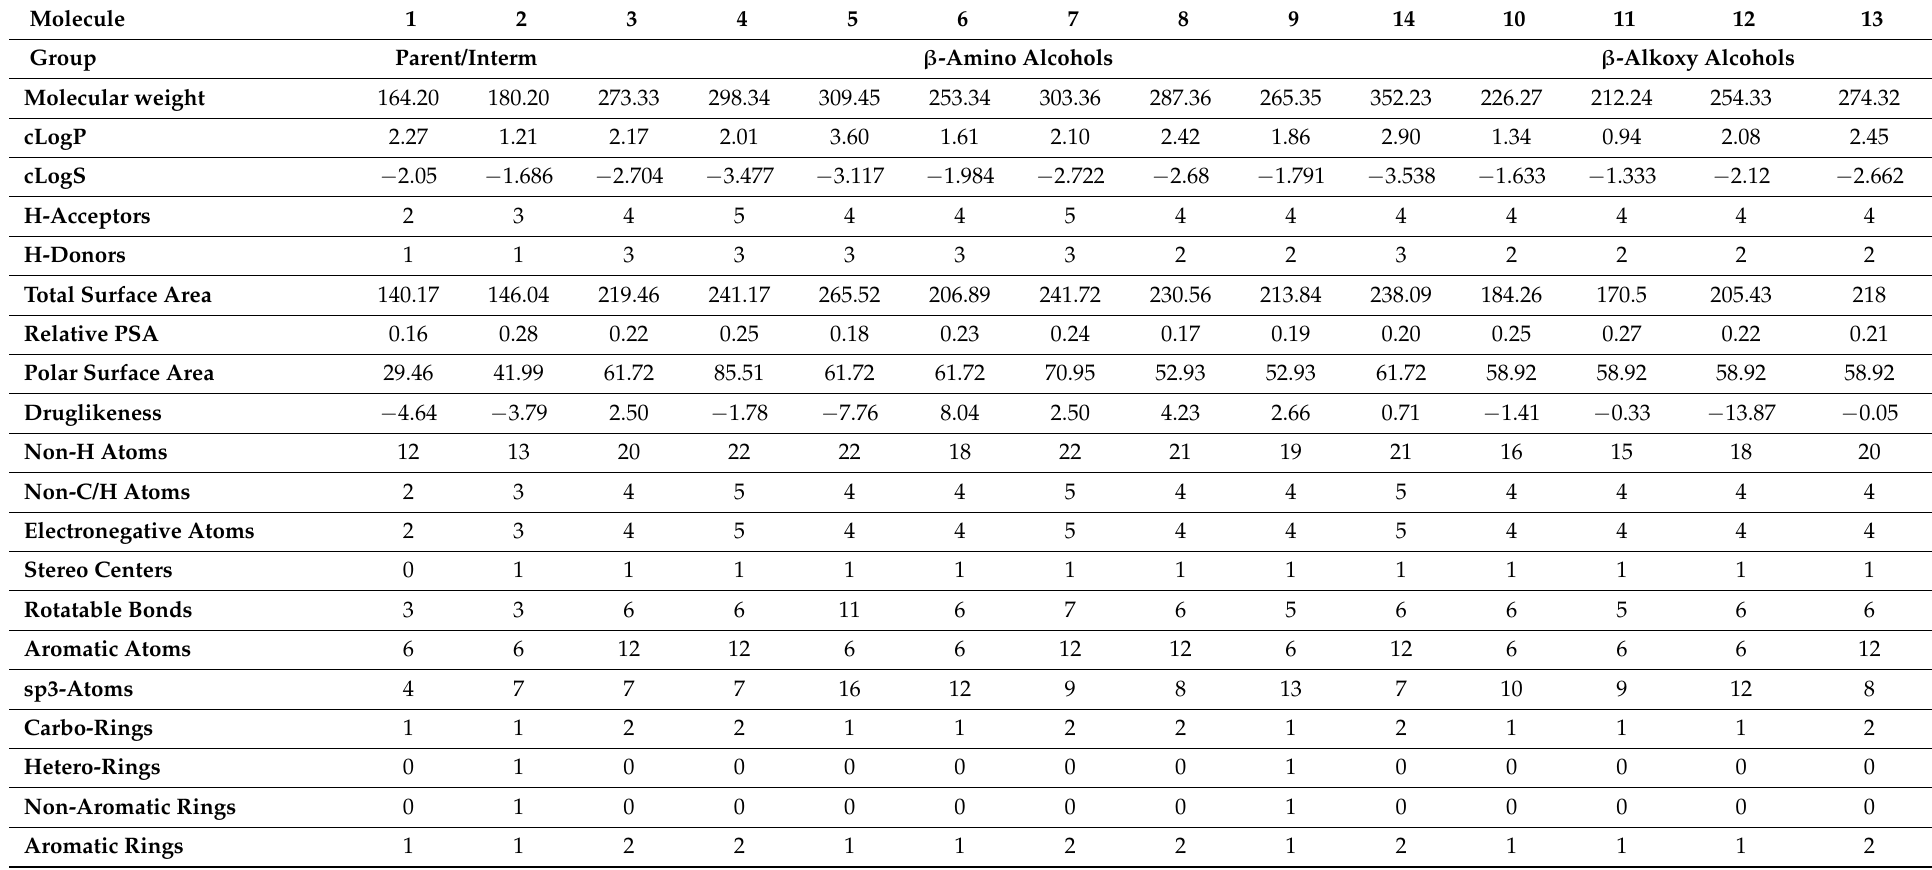
Table 1. Calculated properties of the molecules under study. Interm: intermediate; PSA: polar surface area; VDW: van der